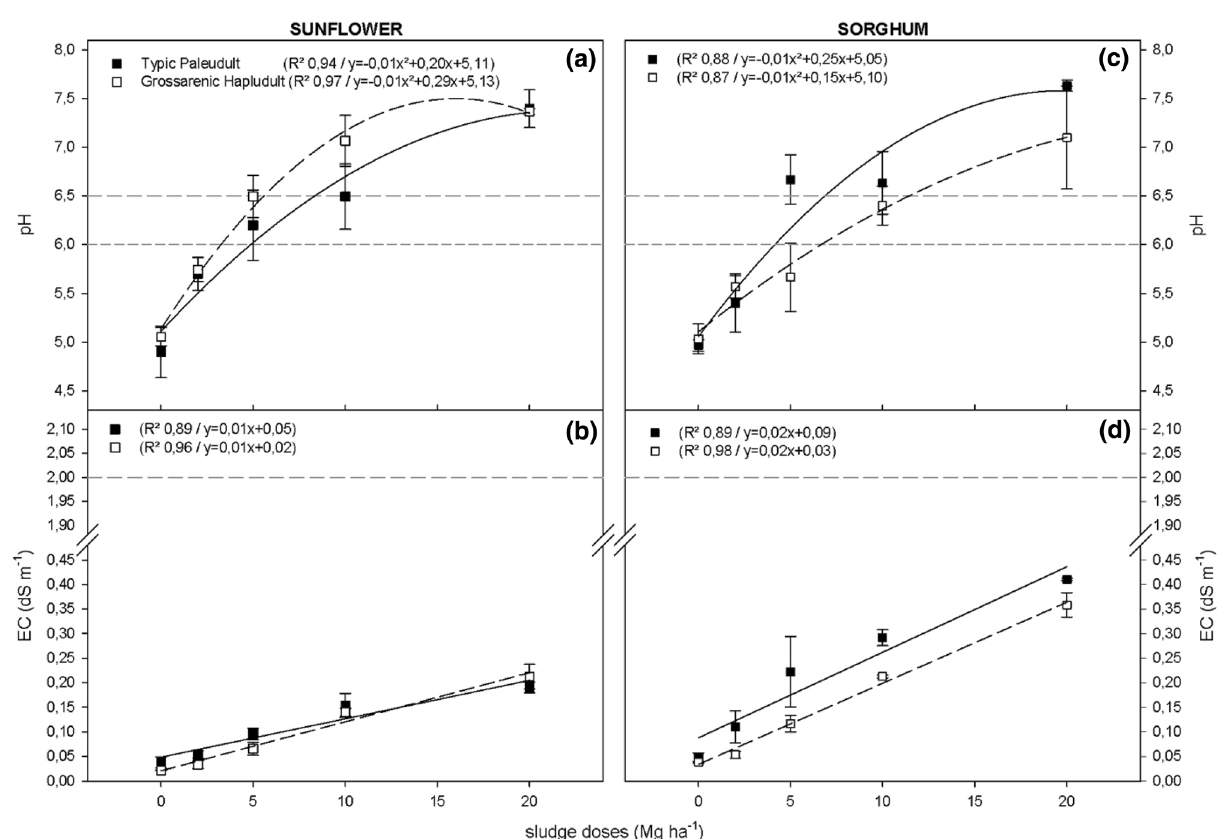
Fig. 2 pH and electrical conductivity (EC) values on Typic Paleudult (filled square) and Grossarenic Hapludult (open square) soils with sun- flower and sorghum cultivation 90 days after the amendment of industrial landfill sludge (ILS) at different doses (0, 2, 5, 10, and 20 Mg ha −1